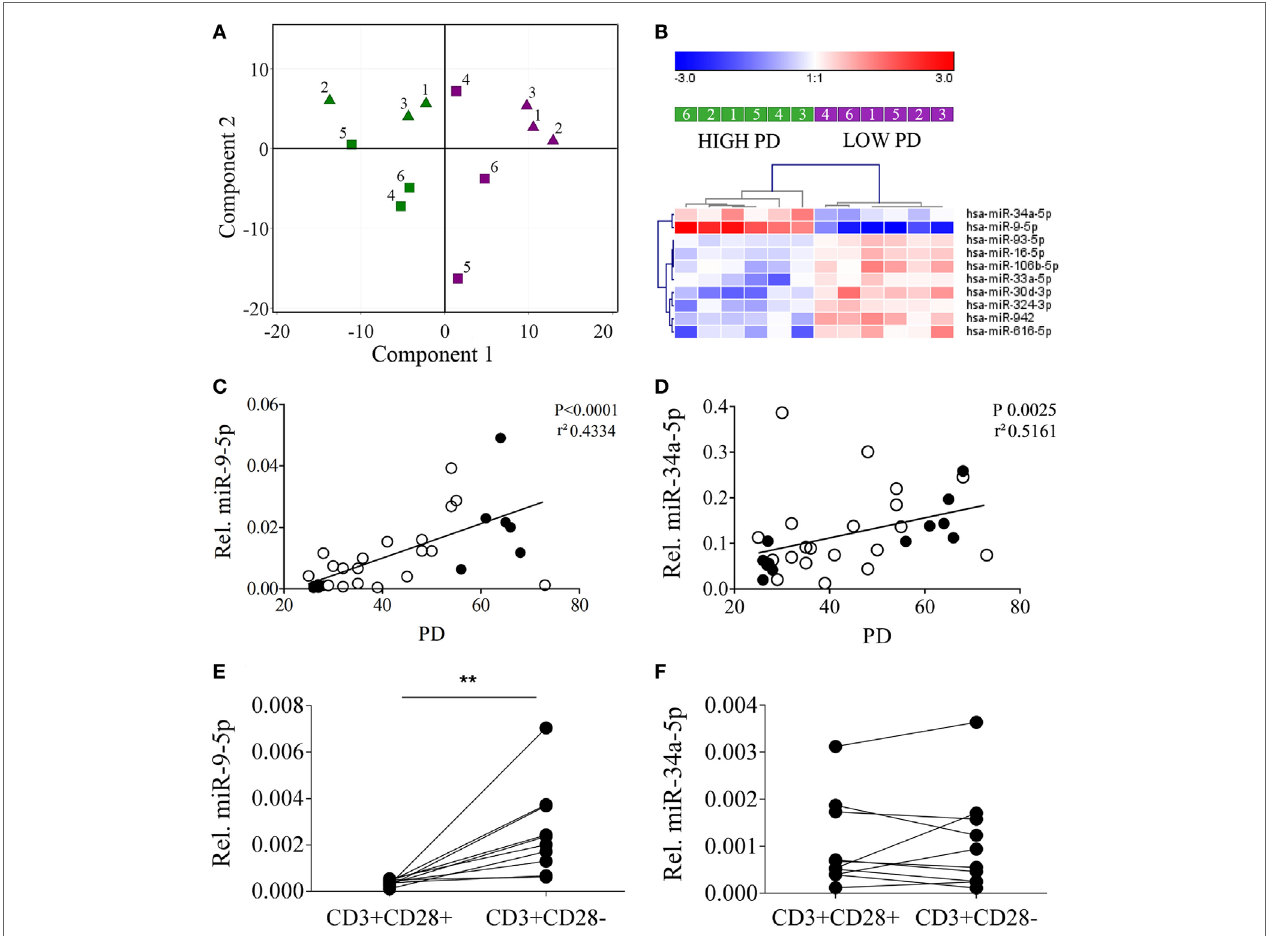
FigUre 2 | MicroRNAs (miRNA) expression analysis in CD4 + T cell clones reveals primarily clusters according to the proliferative history of the T cell clones and partly correlates with the expression of CD28. (a) Principal component analysis identifies low population doublings (PDs) (purple samples) versus high PDs (green samples) as the primary identifier of biological variation for miRNA expression. Triangles indicate young and squares old donors and numbers correspond to the T cell clone numbers indicated in Table S1 in Supplementary Material. (B) Hierarchical clustering of the T cell clones according to low and high PDs based on the 10 most significantly differentially expressed miRNAs. Correlation between (c) miR-9-5p and (D) miR-34a-5p and the PDs of the T cell clones used in the analysis. Filled symbols denote T cell clones used in the small RNA-sequencing samples and open symbols denote additional T cell clones used to validate data from small RNA-sequencing. Significant higher expression of (e) miR-9-5p but not (F) miR-34-5p in fluorescence-activated cell sorting-sorted CD3 + CD28 − T cells versus CD3 + CD28 + T cells. Expression levels of the miRNAs relative to the expression of RNU44 is shown. Significance (** P ≤ 0.01) is